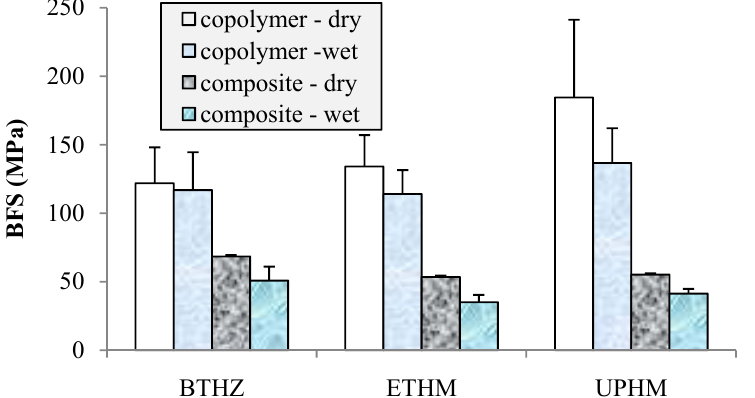
Figure 4. Biaxial flexure strength (BFS; mean value + SD) of dry (before immersion) and wet (after 1 mo immersion in buffered saline solution) copolymer and composite specimens. Number of specimens tested in each group 5 ≤ n ≤